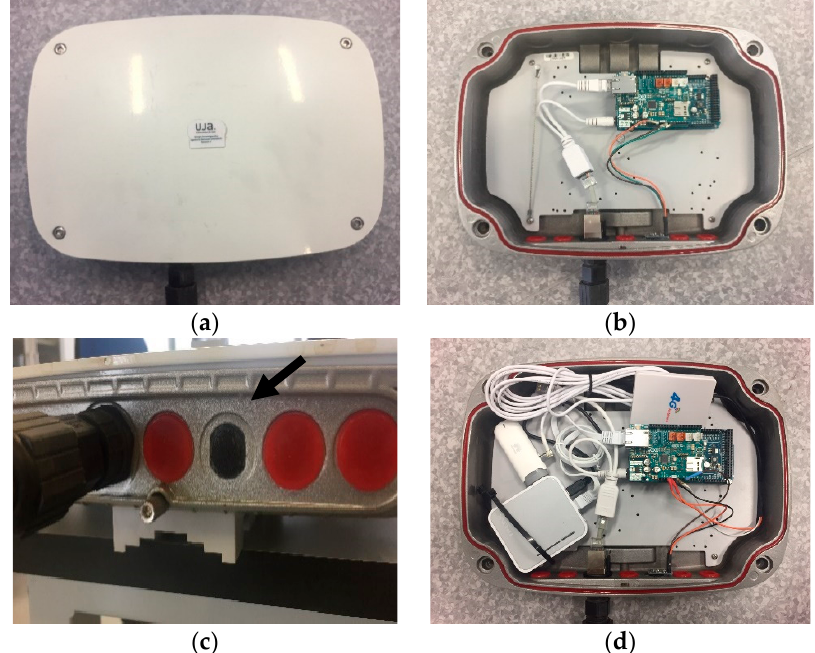
Figure 3. The sensor nodes: ( a ) enclosure box; ( b ) Wi-Fi sensor node; ( c ) microphone; ( d ) 3G sensor node. Table 3. The cost of the sensor nodes.